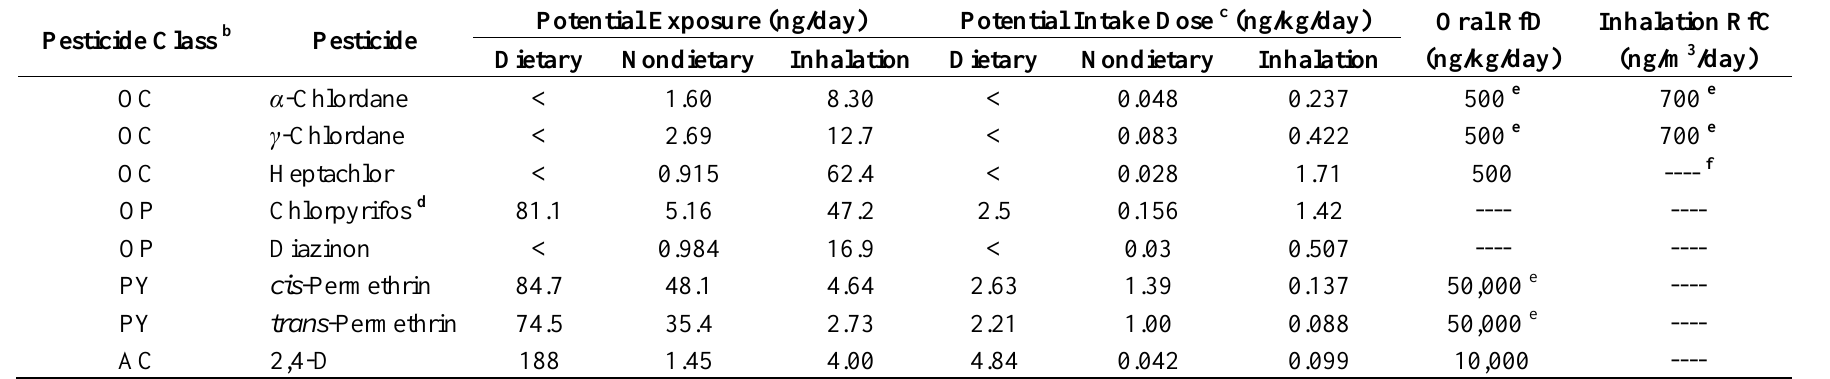
Table 7. The preschool children’s estimated median potential exposures and potential intake doses to frequently detected pesticides by exposure route a